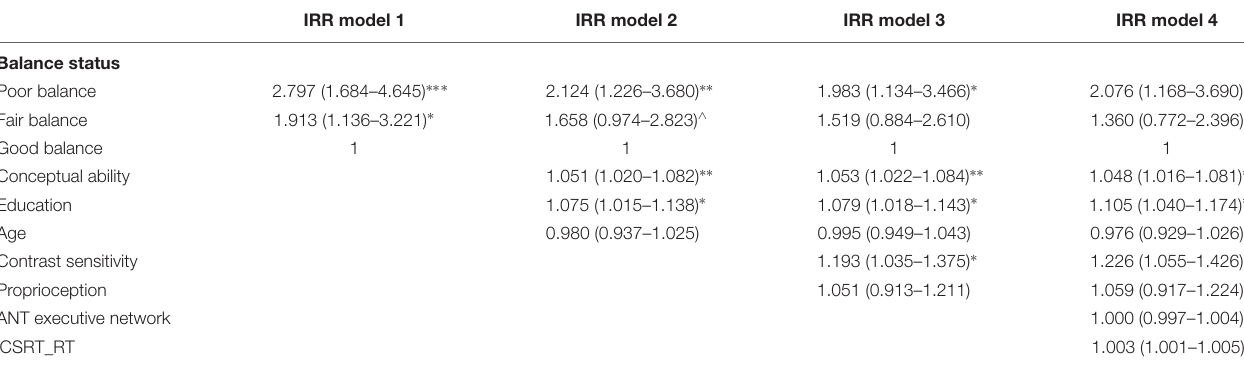
TABLE 4 | Unadjusted and adjusted models for the association between balance status and fall rates with 95% confidence